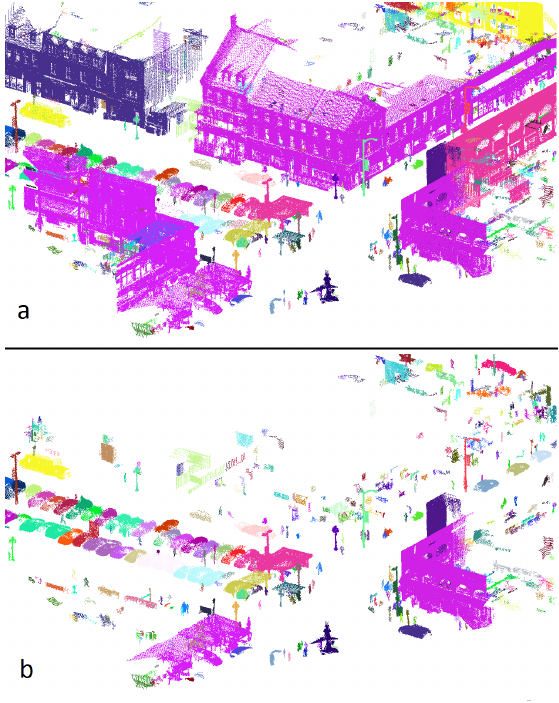
Figure 2: 3D point cloud before filtering (a) and after filtering (b). Different colors correspond to different connected